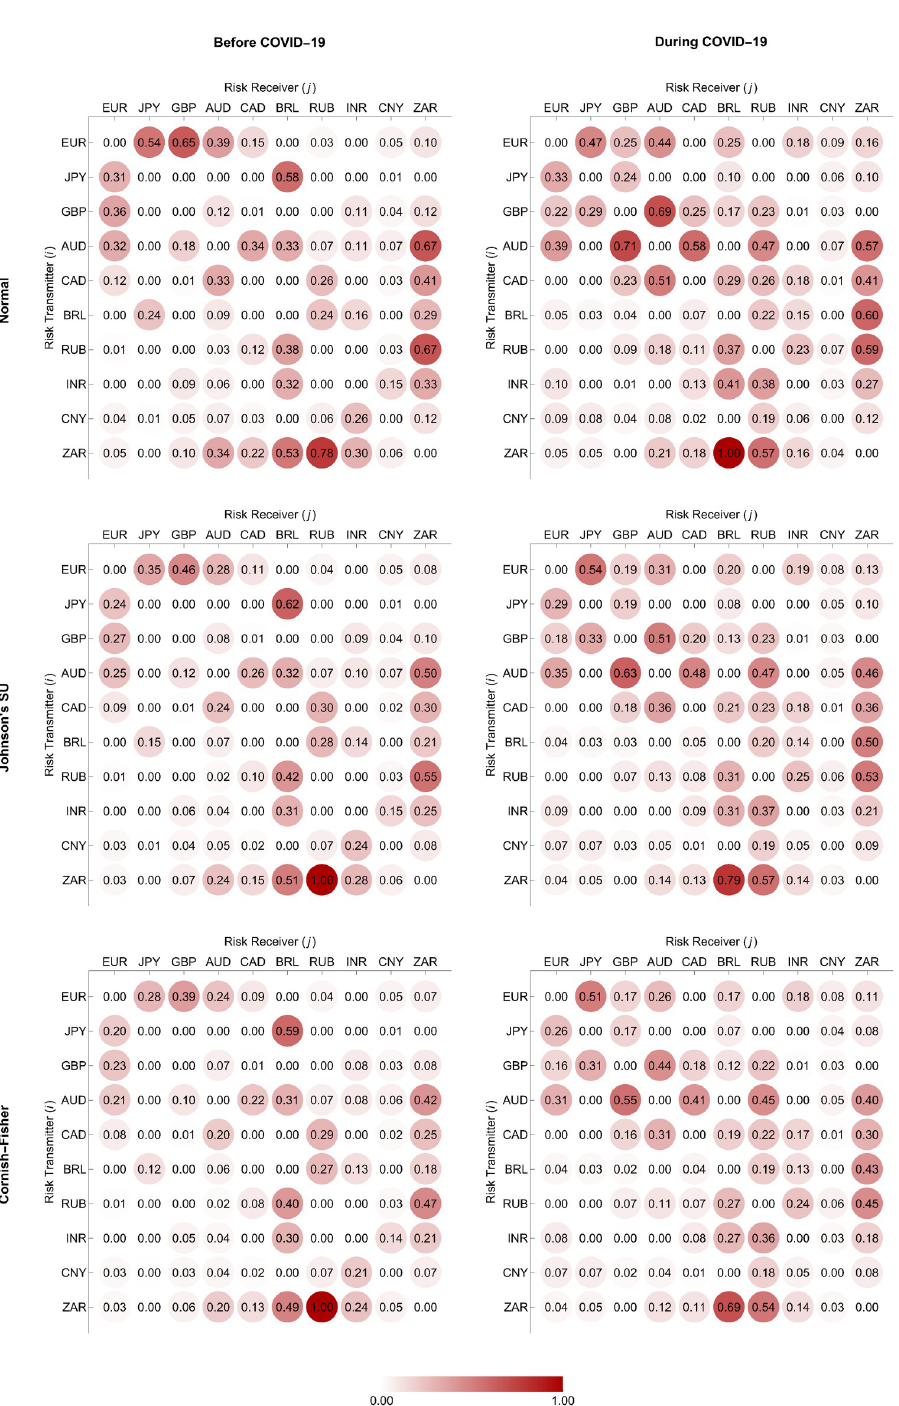
Fig 5. Normalized weighting matrices based on Δ MCoVaR forecasts.